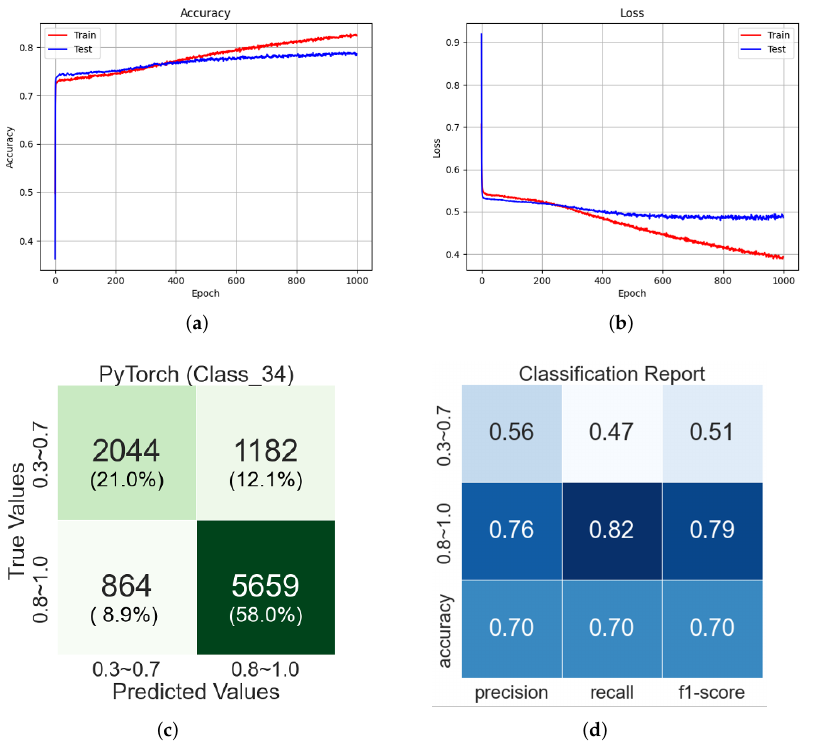
Figure 13. Training results of EfficientNet-B7-based CNN for Step-2-2. ( a ) Accuarcy; ( b ) Loss; ( c ) Confusion matrix; ( d ) Classification